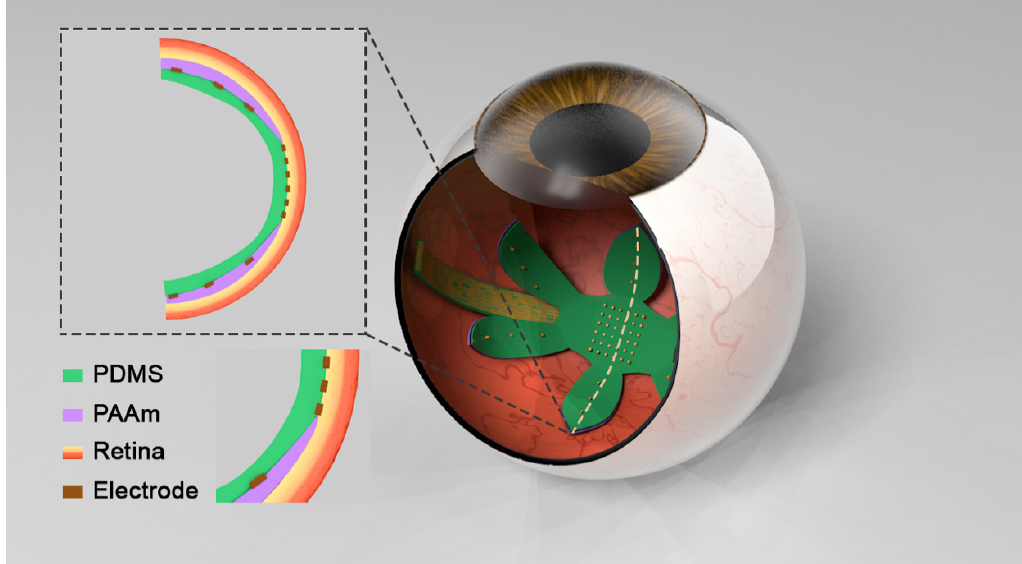
Figure 4. Conceptual illustration of the wide-field bilayer array implanted in the eye. Inserted picture demonstrates the cross-section of the interface between the array and the retina.